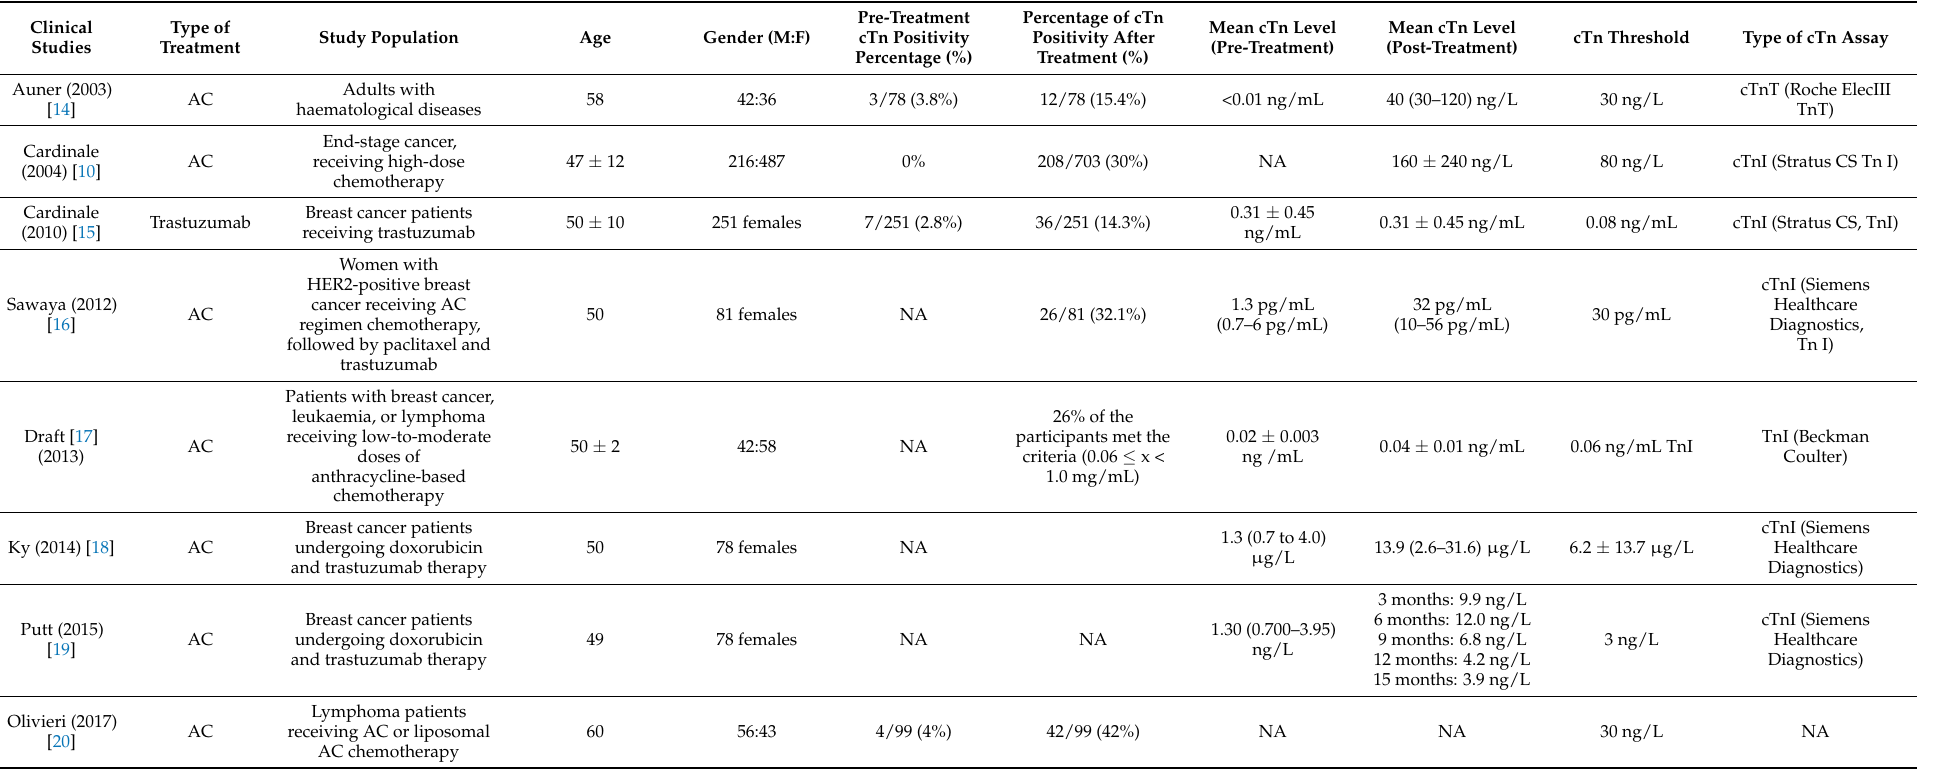
Table 2. cTn is a predictor of CTRCD due to anti-cancer